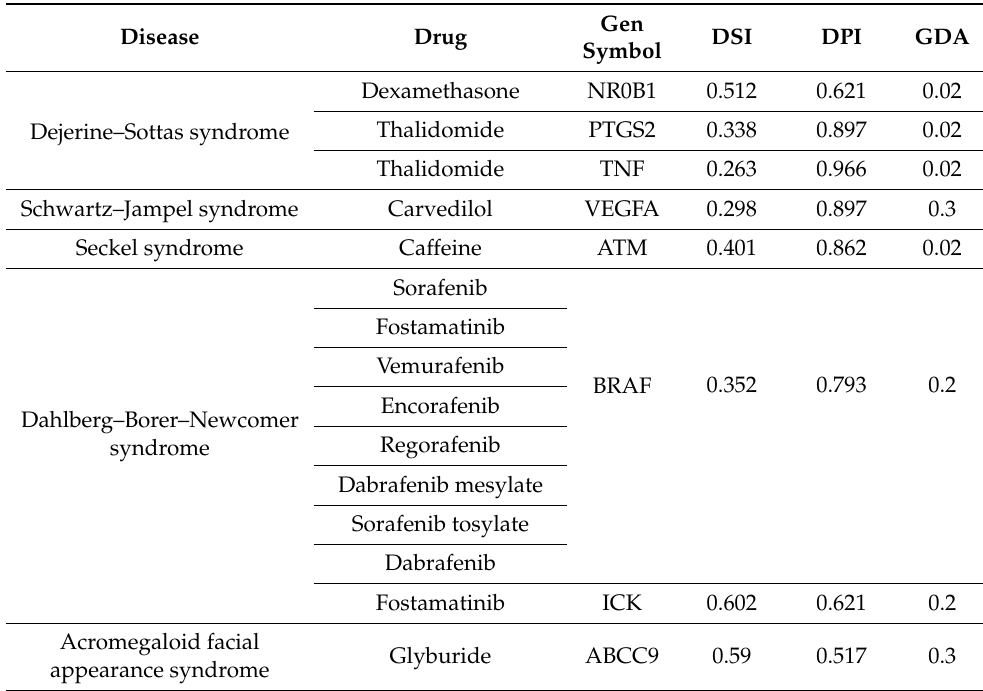
Table 5. Results of the disease–gene association in each of the rare diseases studied according to the target gene of the selected potential